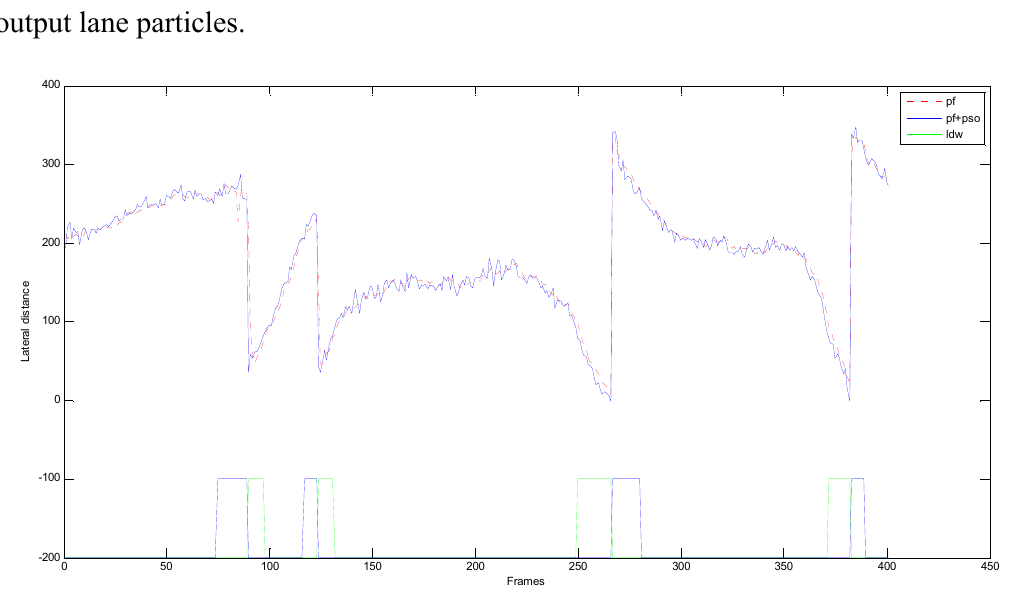
Figure 8. Comparison between Particle Filter and PSO-PF algorithm on the minimum distance of output lane